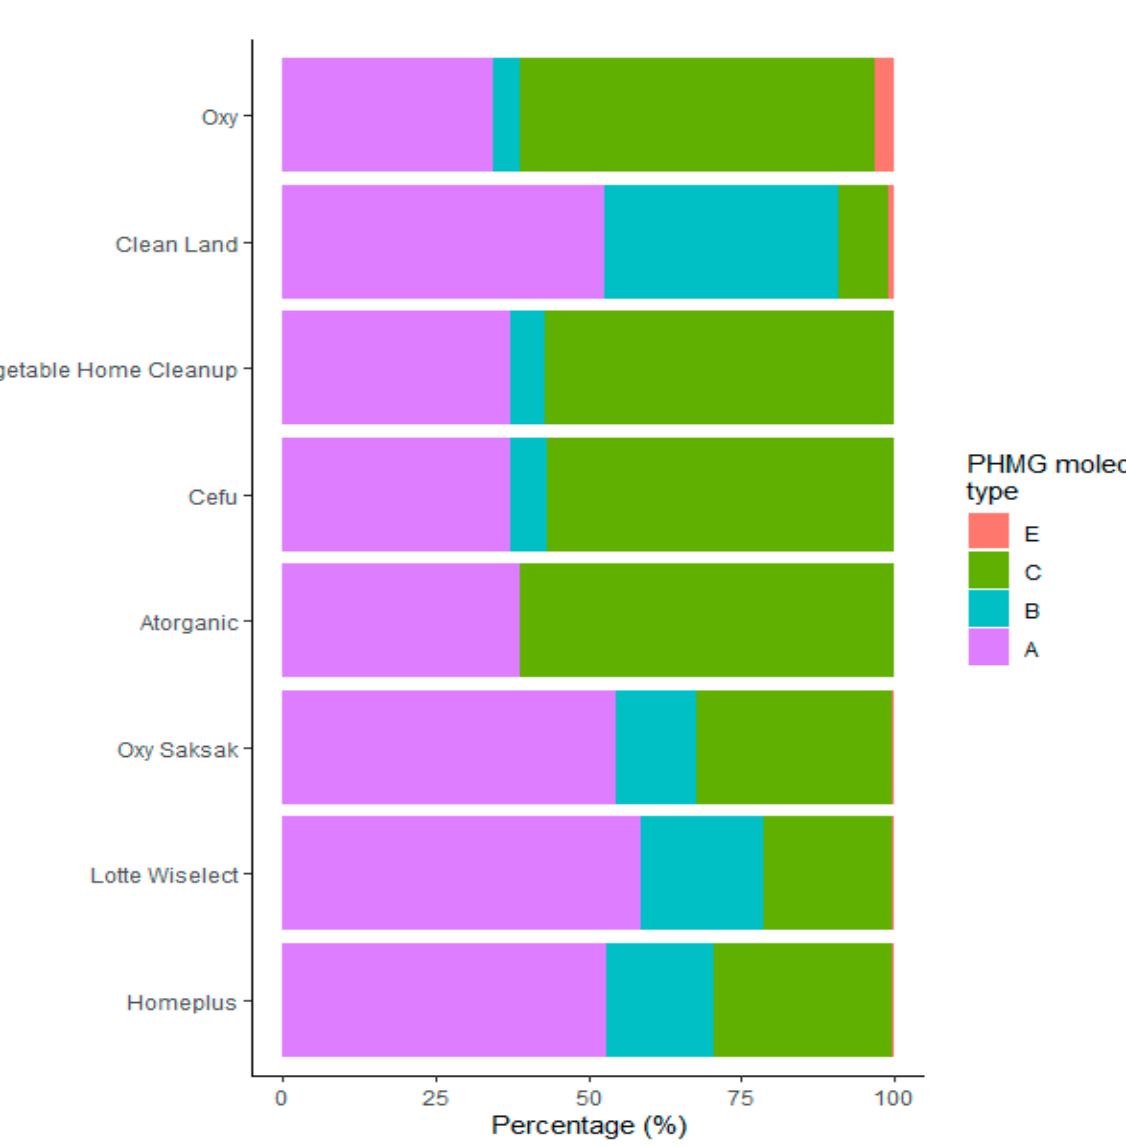
Figure 2. Distribution of molecular types of polyhexamethylene guanidine (PHMG) among types of humidifier disinfectant products.